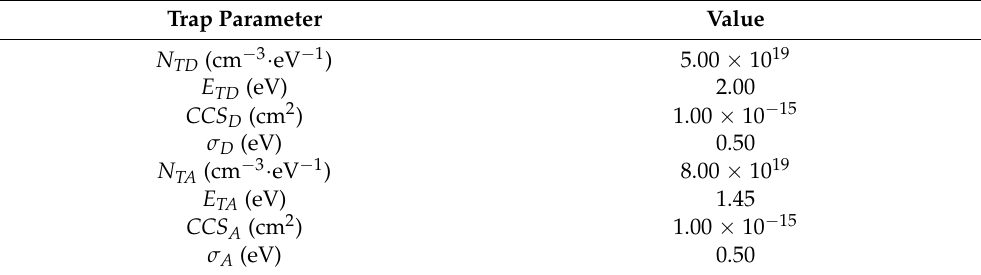
Figure 7. Comparison of optimized values (open, red) and simulated values (closed, black) of V th window. A large value means that the V th window is widened. Table 2. Optimized input parameters of energetic-trap distributions of the CTN.